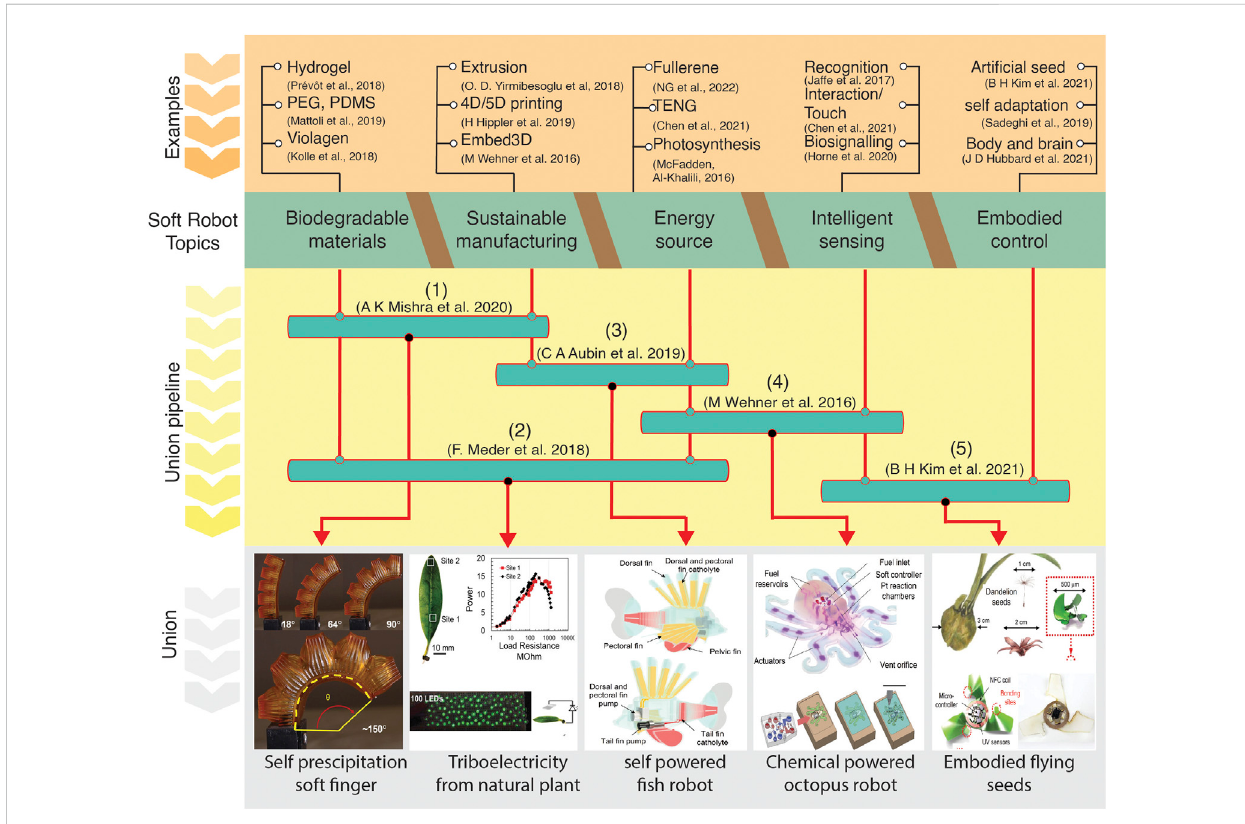
FIGURE 2 ThemesofsoftroboticswithintheframeworkoftheUnitedNations ’ SustainableDevelopmentGoals.Illustrationsofhoweachthemecontributesto thedevelopment ofsoftrobots. Examplesofhowsynergizingdifferentthemesresults inpowerful softrobotics.Ourvision ofwhatthefutureholds when we unite all fi ve elements to create a practical, fi eld-ready soft robot that supports